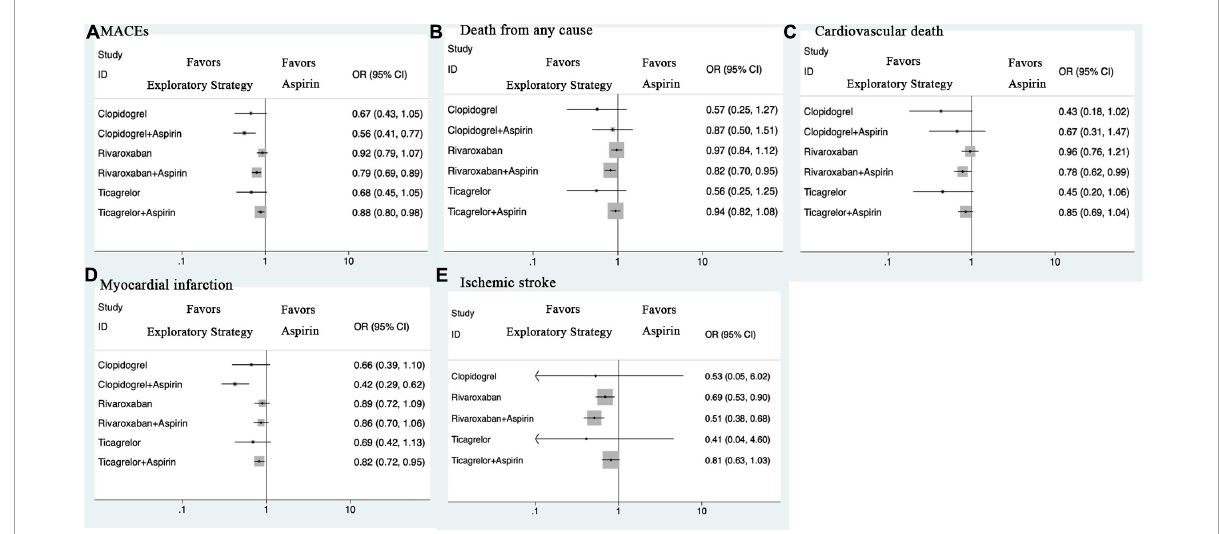
FIGURE2 Forest plots for efficacy outcomes. (A) MACEs. (B) Death from any cause. (C) Cardiovascular death. (D) Myocardial infarction. (E) Ischemic stroke. CI, credible intervals; MACEs, major adverse cardiovascular and cerebrovascular events; OR, odds ratio.